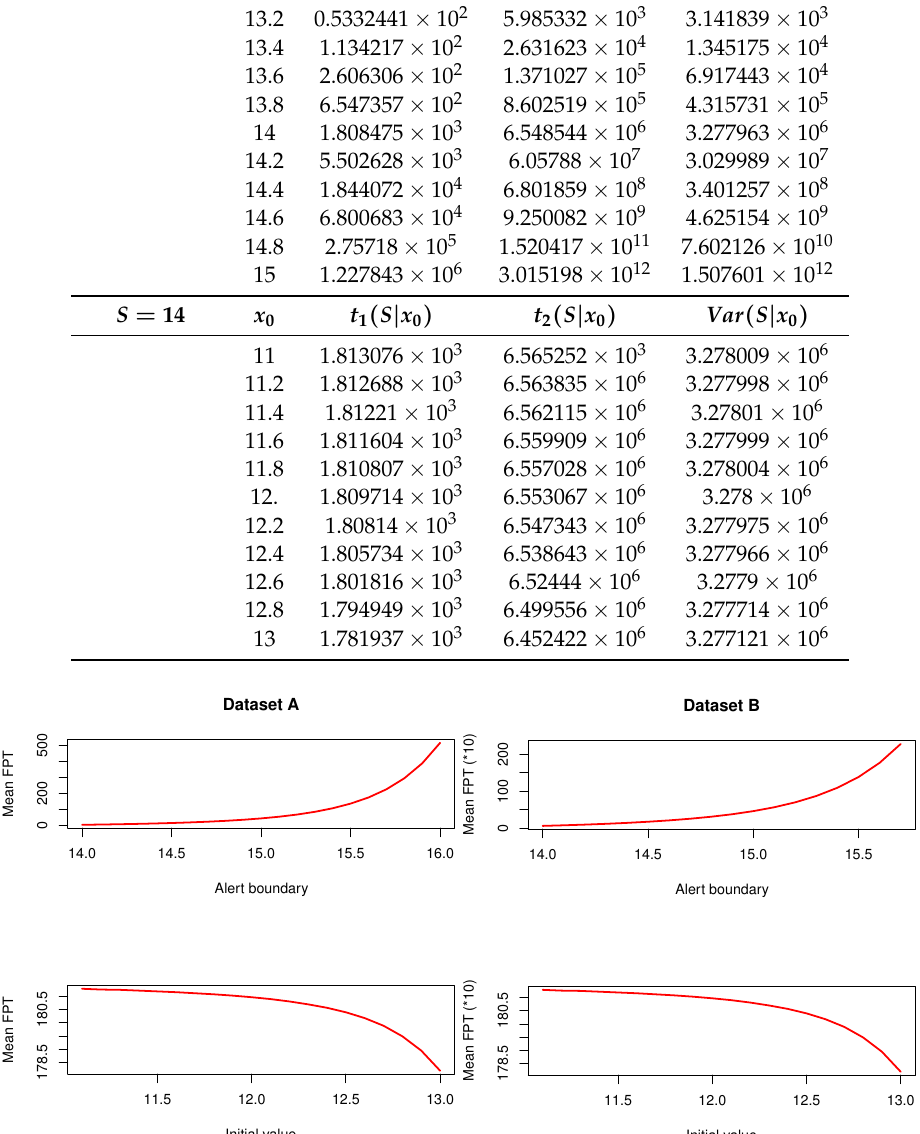
Figure 4. Mean FPT versus the alert boundary ( x 0 = 13.28) and the initial value x 0 ( S = 15) for Dataset A, second period ( left ), and for Dataset B, second period ( right